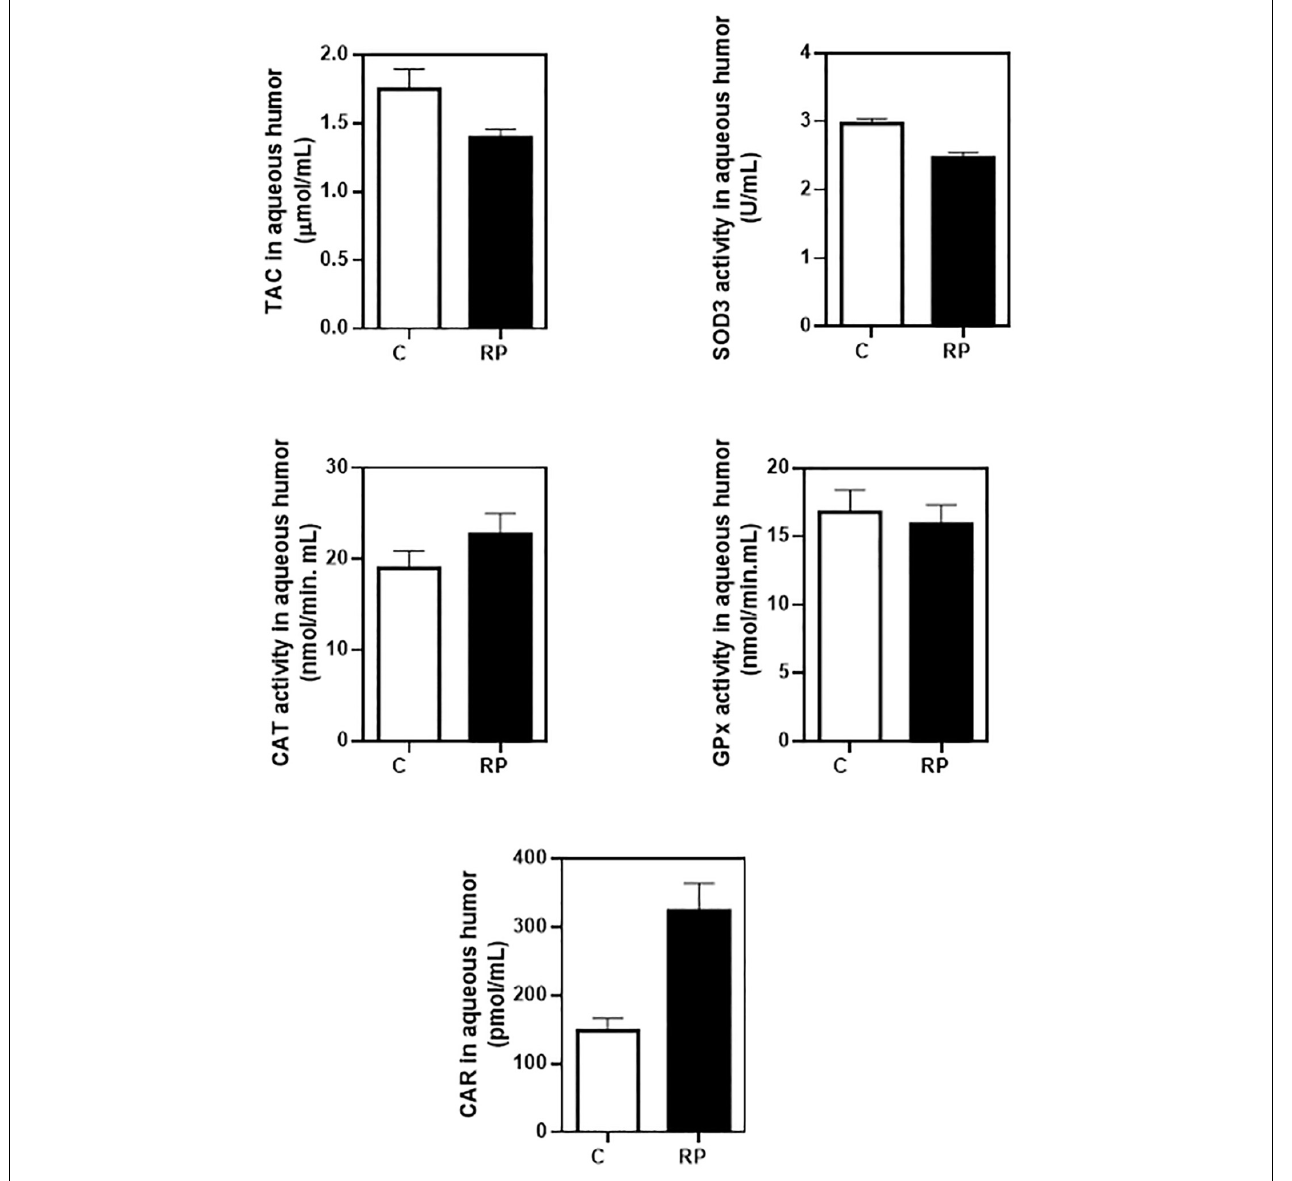
FIGURE 3 | Baseline concentrations of antioxidant and oxidant markers in aqueous humor of controls and RP patients. Ocular redox status was determined by measuring total antioxidant capacity (TAC), extracellular superoxide dismutase (SOD3), catalase (CAT) and glutathione peroxidase (GPx) activities, and protein carbonyl adduct (CAR) content with commercial kits. All data were plotted in bar graph with standard error bars. C, control subjects; RP, patients with retinitis